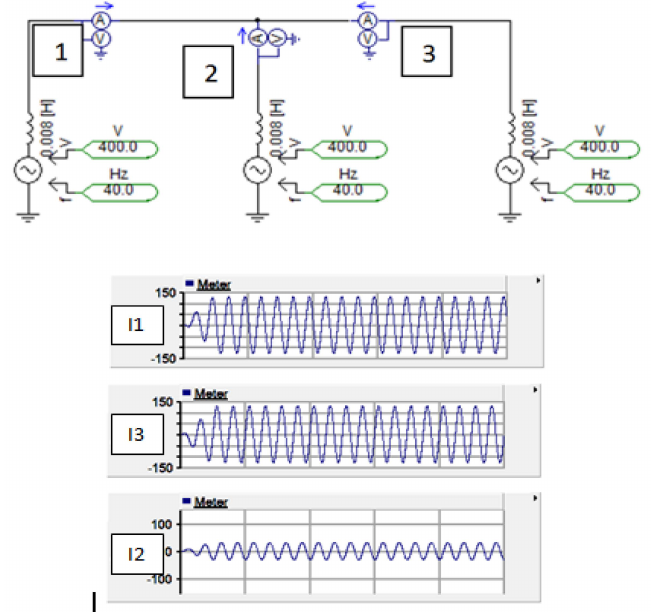
Figure 6. At no load, the adjacent coils, which belong to the same phase, are connected in parallel. The induced FEM are not synchronous and circulating currents exist. In this example, three coils are connected (1, 2, and 3) and the circulating currents I1, I2, and I3 are plotted. They can be as high as 30% of the rated current and are not visible in power supply lines.